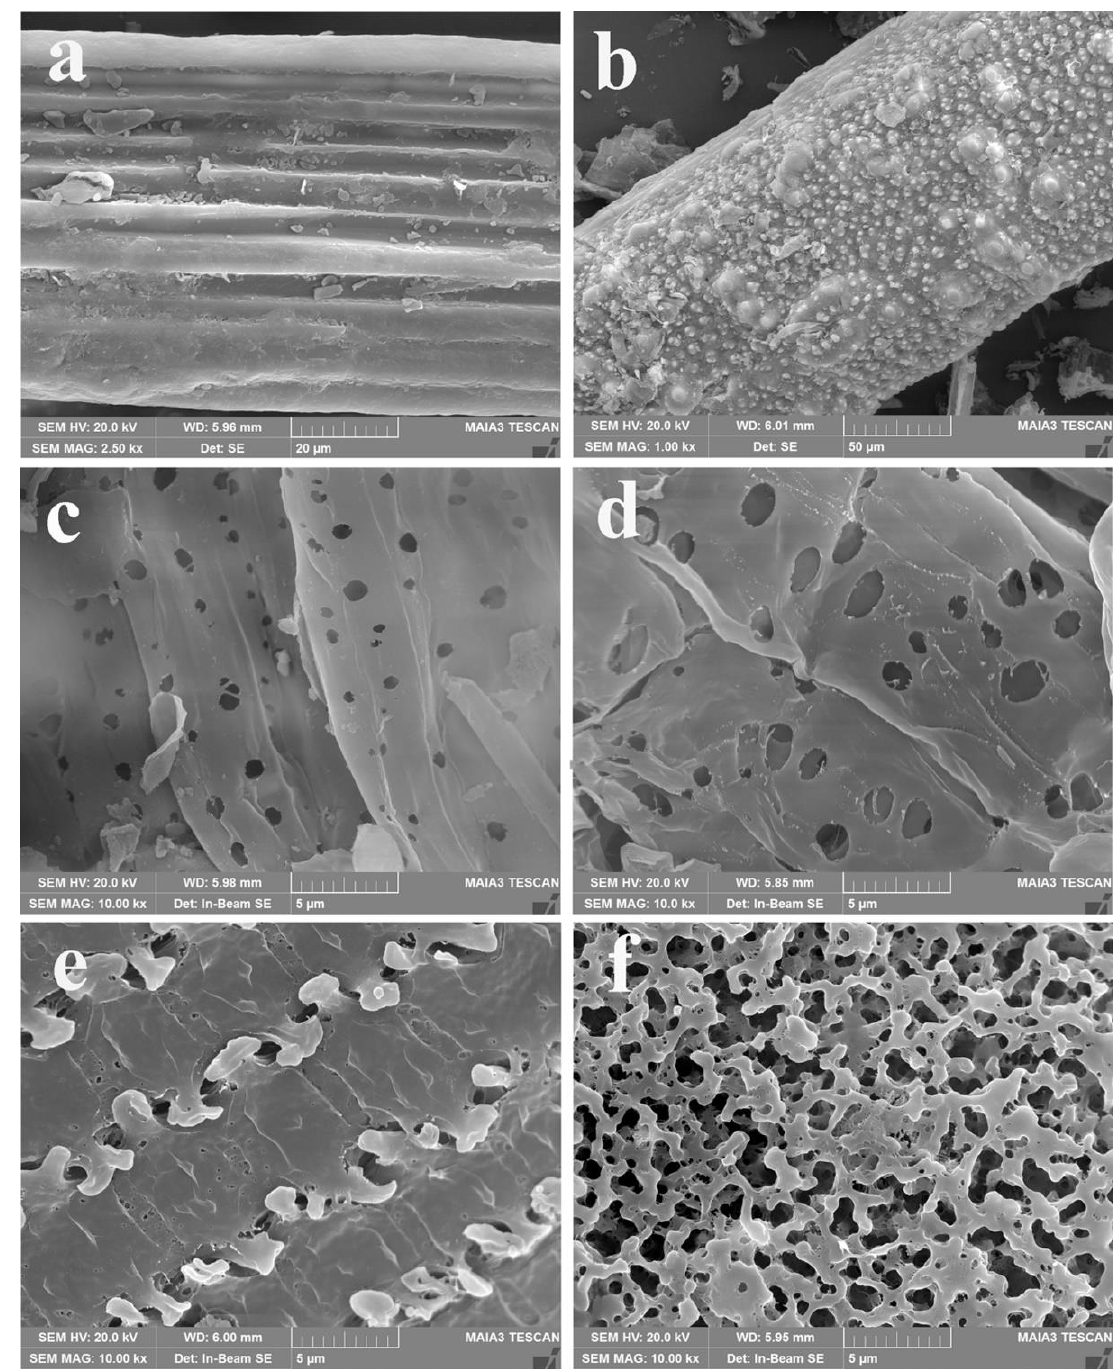
Figure 7. SEM images: ( a ) rice straw powder, ( b ) pretreated rice straw, ( c ) pretreated rice straw after secondary washing by C 2 H 5 OH/H 2 O solution, ( d ) rice straw-derived coarse cellulose, ( e ) RSC, ( f ) RSCA.